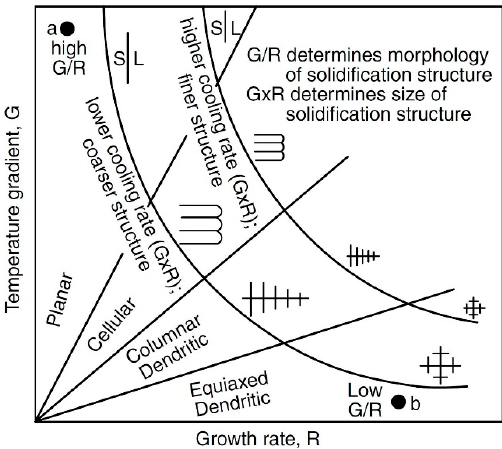
Figure 3. Solidification map showing the effect of temperature gradient and growth rate on the morphology and size of the resulting microstructure